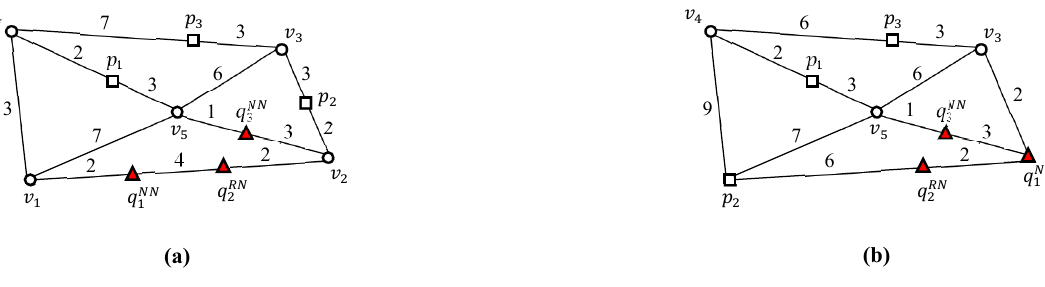
} : ( a ) at time t , q RN , q NN i . 2 3 1